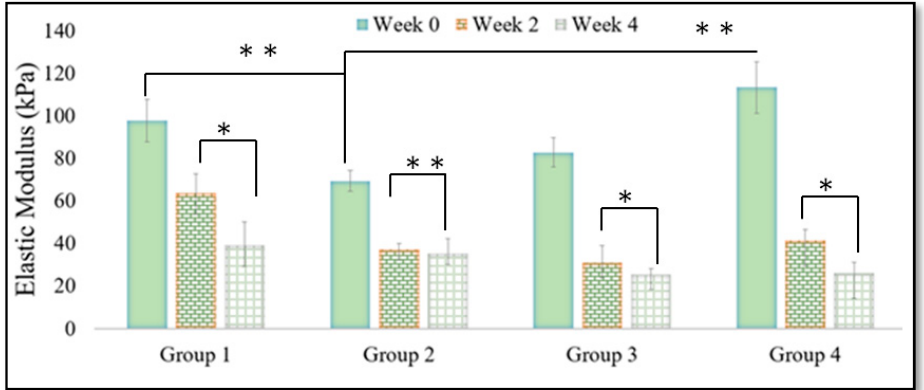
Figure 3. The compressive strength of the scaffolds of varying composition over time is shown here. Statistical significance was calculated using a Student’s t-test (* was, and ** were used to represent p < 0.05 and p < 0.01, respectively).